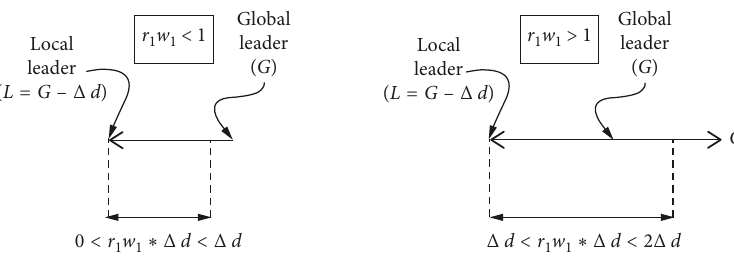
Figure 2: w range for local female 2